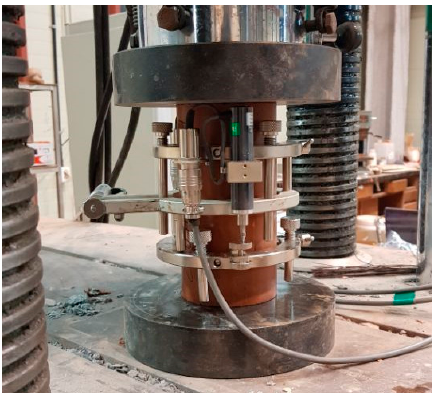
Figure 5. Test setup for the compression loading test.